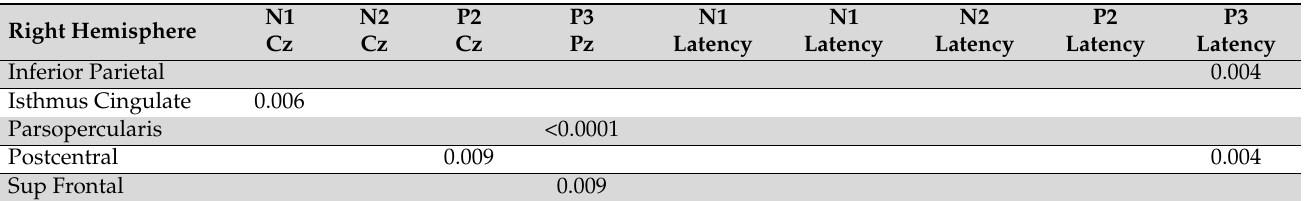
Table 3. Bivariate correlations between amplitude and latency of ERP components and FreeSurfer regions in the right hemisphere (N = 217).